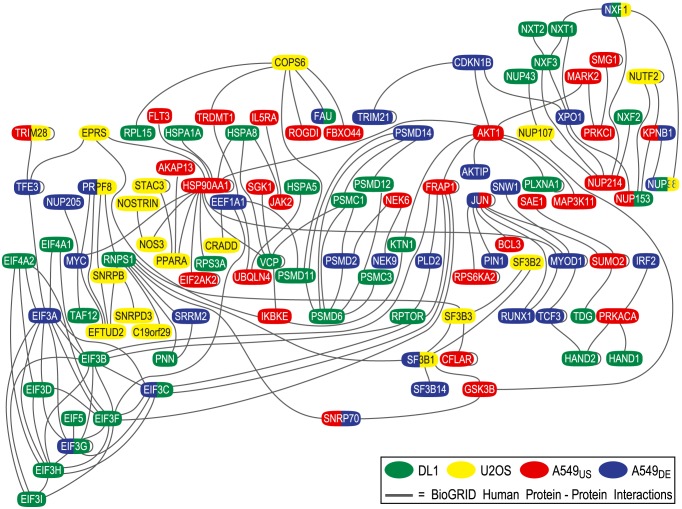
Connected component from the physical interaction network illustrates connections of four studies.The largest connected component from the physical-interaction graph which was derived by pooling genes implicated in the four RNAi studies. This connected component consists of 108 genes. Each oval represents an implicated gene, and its color (or colors) indicates the study (or studies) in which it was confirmed. Edges represent protein-protein interactions among gene products. Genes confirmed by each individual study tend not to be topologically clustered, but instead generally have interactions with genes confirmed by other studies.